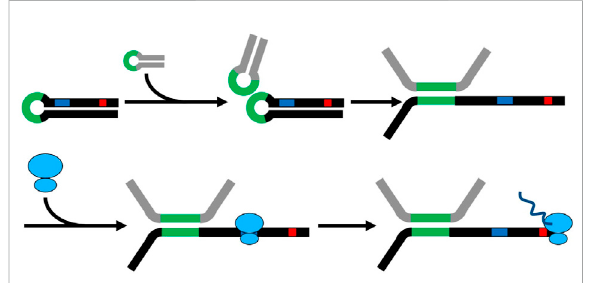
FIGURE 6 Model for regulation and enabling of translation by Assolrna. Black, sol mRNA with possible RBS (blue) and start codon of respective coding sequence (red); grey, Assolrna; green, possible interaction sites of sol mRNA and Assolrna; blue ovals, ribosome; dark blue, synthesized peptide by ribosome. The model was inspired by (Watson and Mörl, 2011) and is modi fi ed from Baur